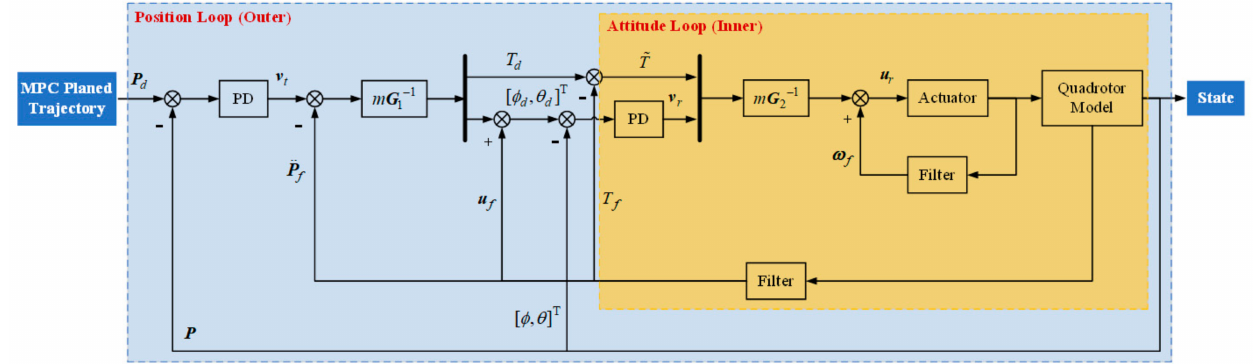
Figure 4. Block diagram of our quadrotor cascade INDI controller in position and attitude